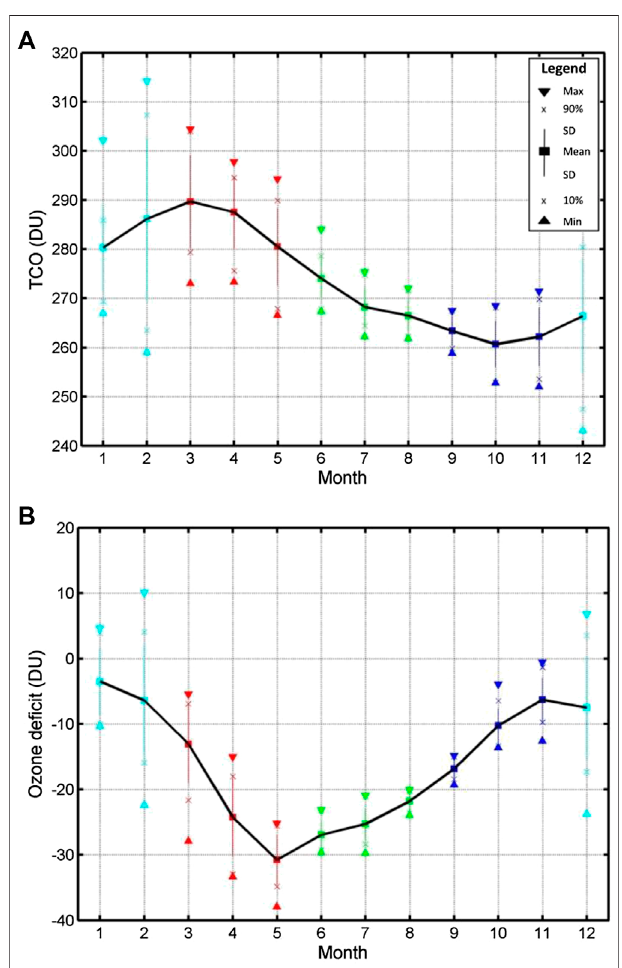
FIGURE2| SeasonalvariationofthemonthlyTCOmeanovertheTP (A) and the ozone de fi cit (B) using OMI data from October 2004